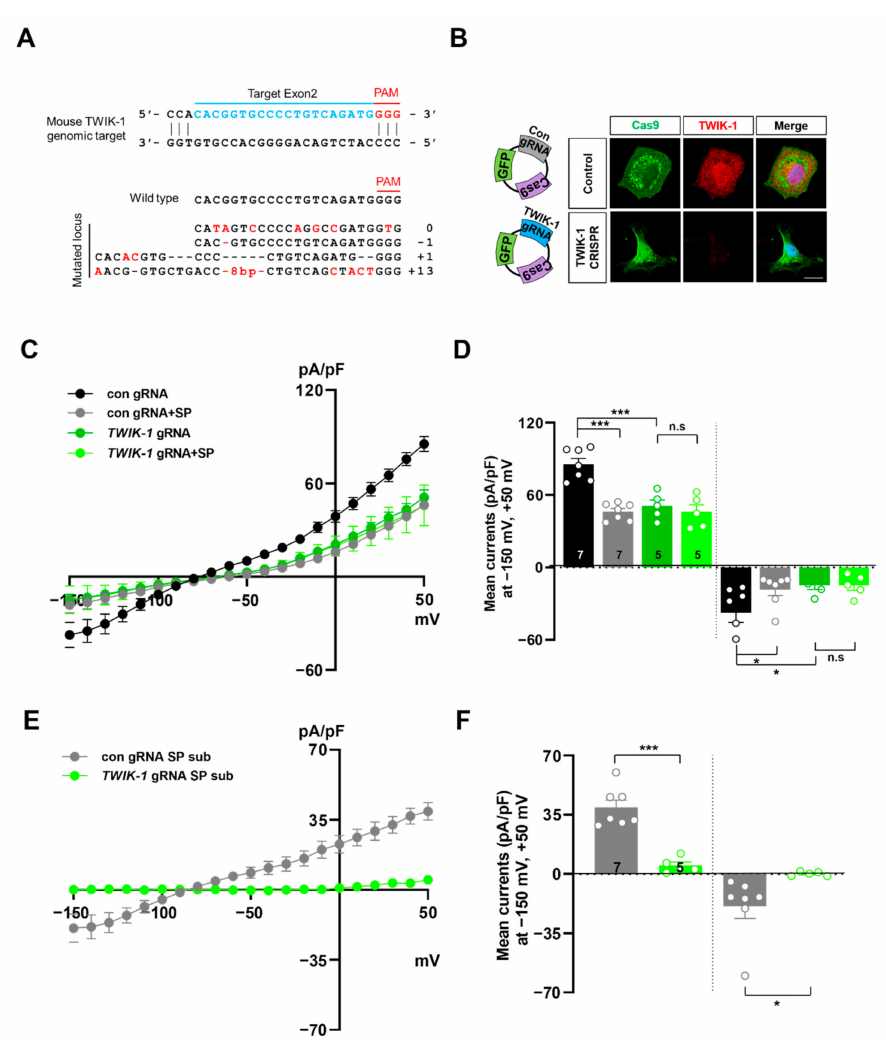
Figure 4. Spadin inhibits TWIK-1 mediated K + currents in a TREK-1-dependent manner in cultured astrocytes. ( A ) Schematic representation of the genomic structure of the TWIK-1 gene. Target sequences of gRNA are located within exon2 of mouse TWIK-1 gene. Examples of indel mutations are displayed. ( B ) Immunocytochemical images of control gRNA (Con gRNA) or TWIK-1 gRNA transfected cultured astrocytes stained with anti-TWIK-1 antibody. ( C ) Current densities before and after application of 10 µ M spadin (SP) to control gRNA or TWIK-1 gRNA transfected astrocytes. ( D ) Summary bar graph of control gRNA or TWIK-1 gRNA currents with or without spadin (SP) plotted at + 50 mV and − 150 mV. The number on each bar indicates n for each condition. All values are mean ± s.e.m. p -values were obtained with one-way ANOVA followed by Turkey’s post hoc test. n.s: not significant, * p < 0.05 and *** p < 0.001. ( E ) Subtract spadin (SP-sub) treatment currents from before application of spadin currents in control gRNA or TWIK-1 gRNA transfected astrocytes. ( F ) Summary bar graph of con gRNA (Con gRNA-SP sub) or TWIK-1 gRNA ( TWIK-1 gRNA-SP sub) spadin-subtracted currents plotted at + 50 mV and − 150 mV. Th number on each bar indicates n for each condition. All values are mean ± s.e.m. p -values were obtained with Student’s t -test. * p < 0.05 and *** p <